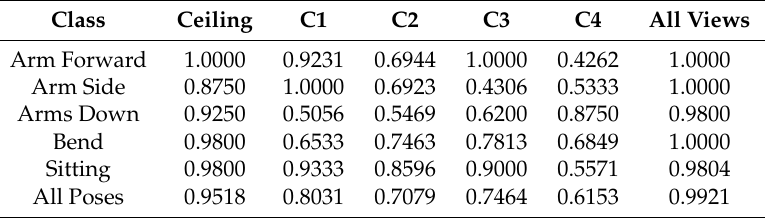
Table 4. Precision results from the five TISSs test where C =